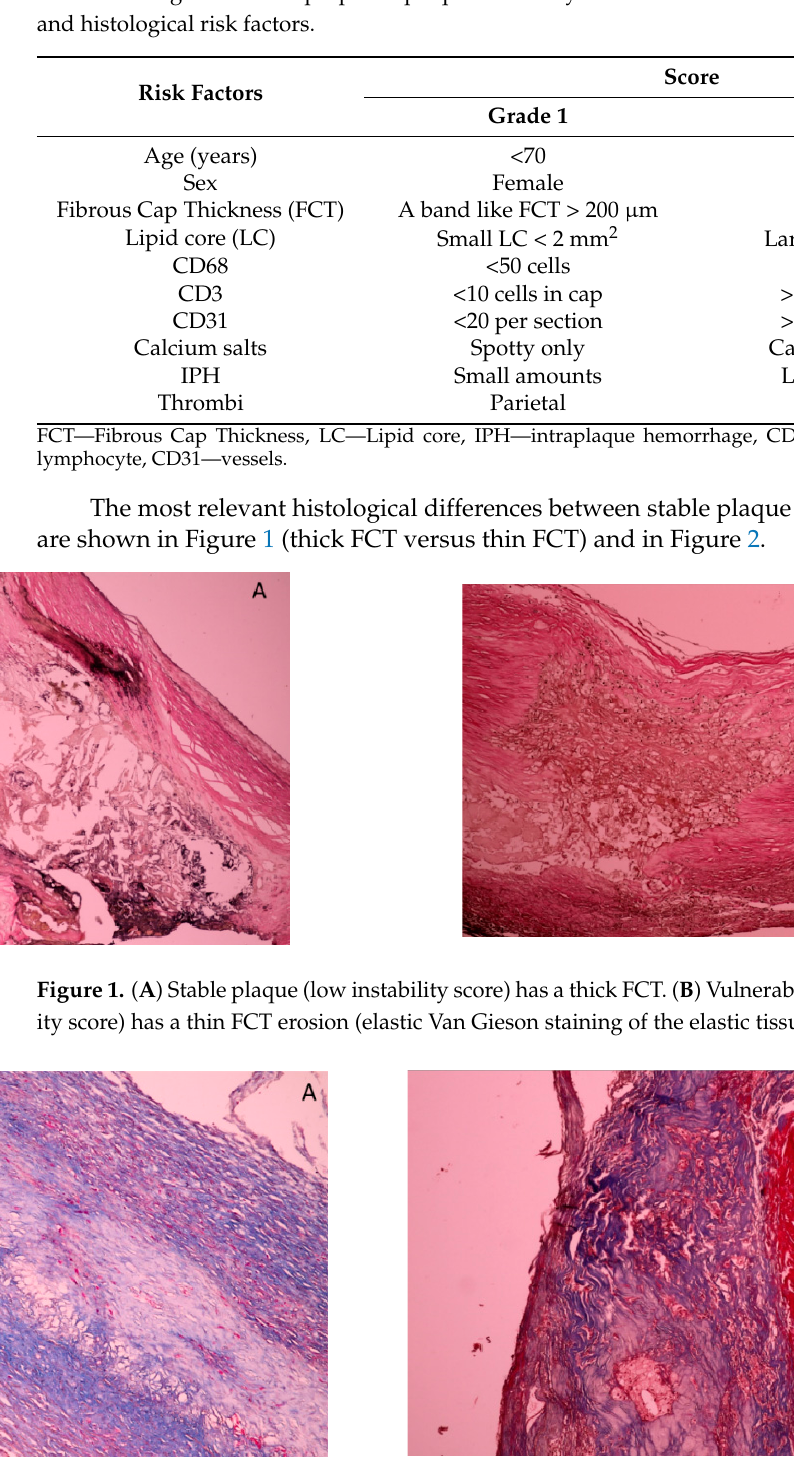
Figure 2. ( A ) Stable plaque (low instability score) has a thick FCT. ( B ) Unstable plaque (high instability score) has a parietal thrombus on endothelial erosion (elastic Van Gieson staining of the elastic tissue; × 20